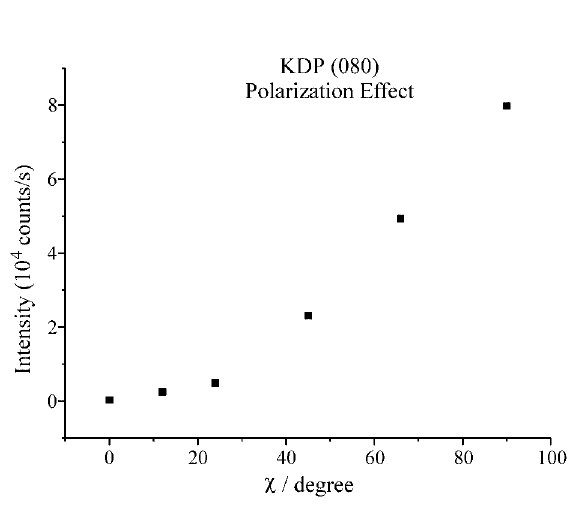
Figure 2. Effect of the variation of the synchrotron linear polarization with respect to the diffractometer incidence plane to the (080) KDP intensity.